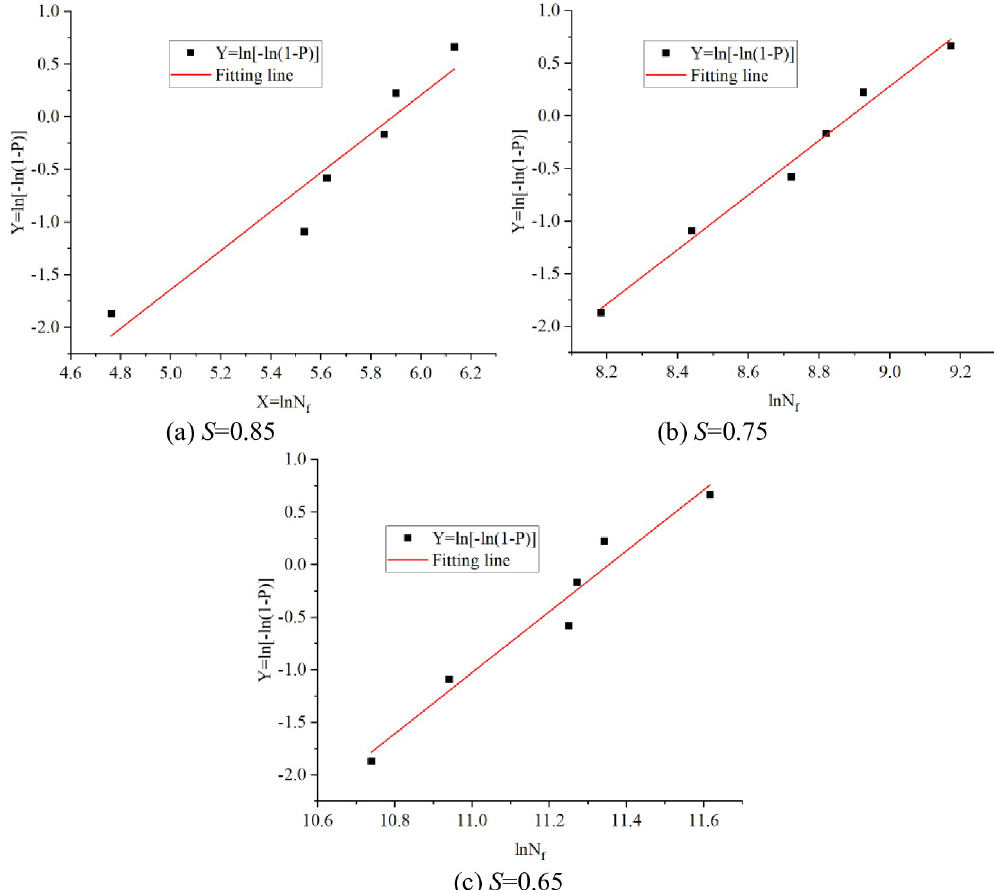
Fig 4. Weibull distribution test for bending fatigue life of specimens. (a) S = 0.85. (b) S = 0.75. (c) S = 0.65.